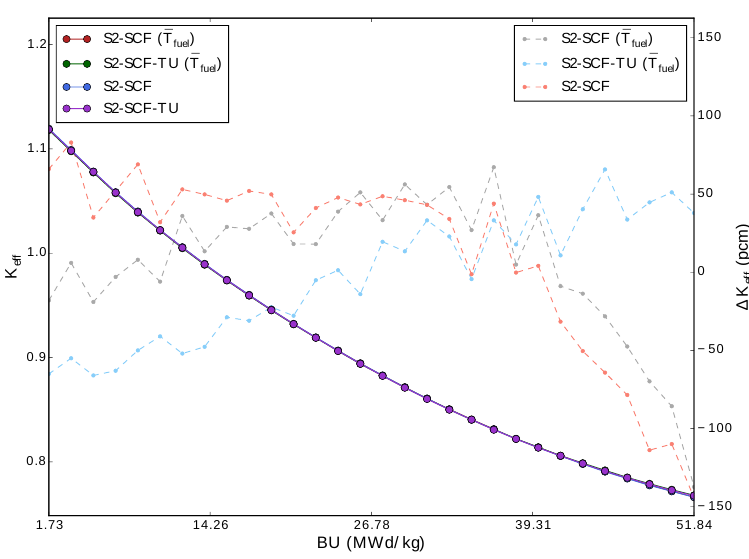
Figure 3: Multiplication factor.